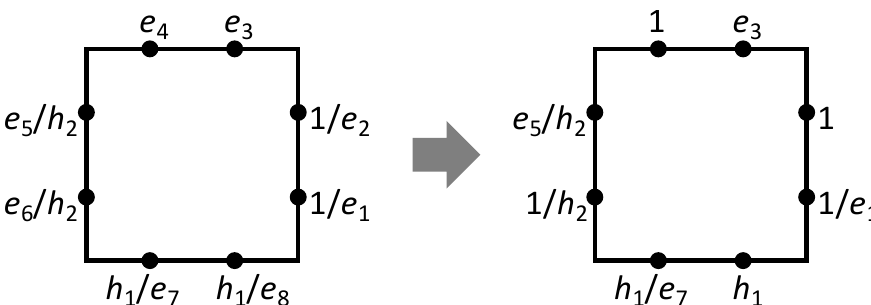
Figure 9 . Asymptotic values for the D 5 curve: the original asymptotic values (left) and the values after fixing the conditions in (A.5)